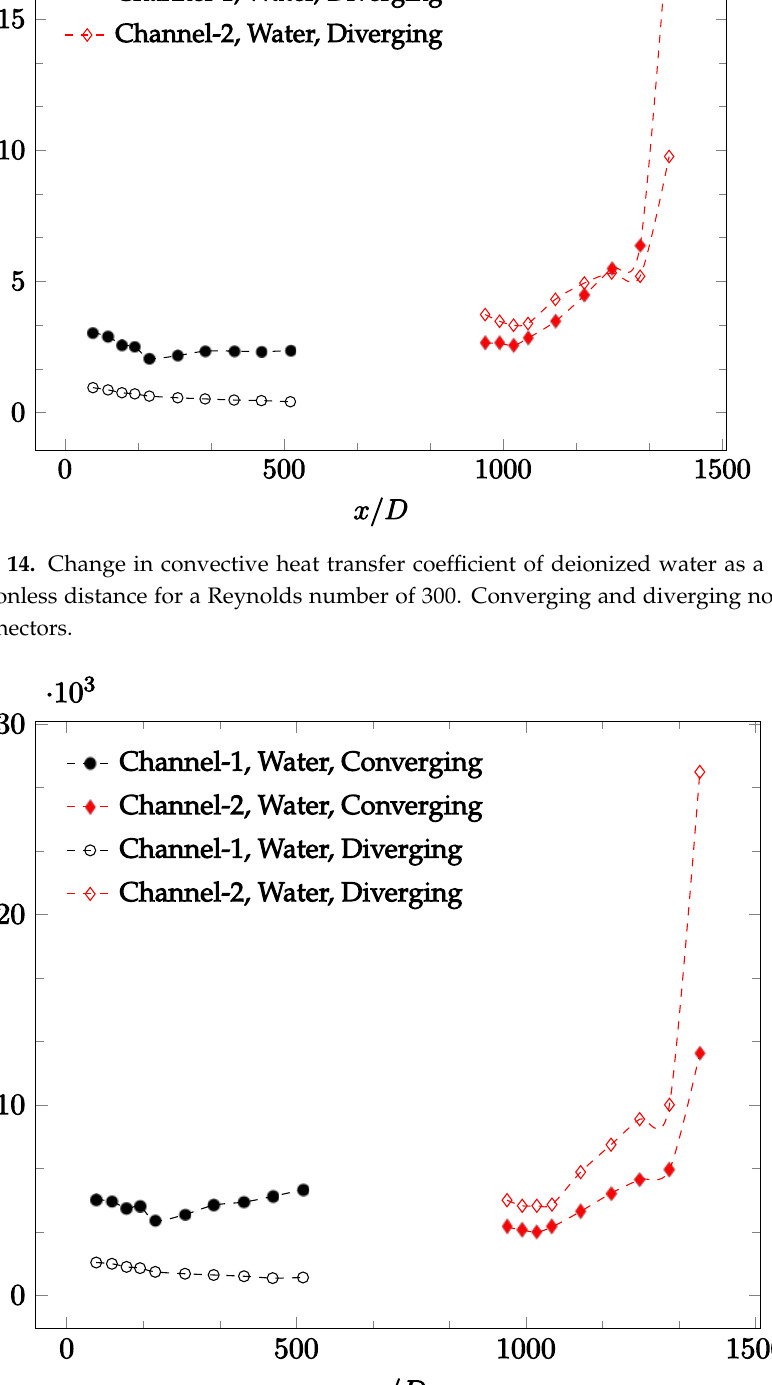
Figure 15. Change in convective heat transfer coefficient of deionized water as a function of dimensionless distance for a Reynolds number of 400. Converging and diverging nozzles are used as connectors.